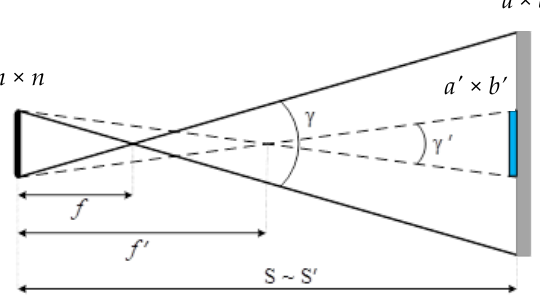
Figure 7. Image acquisition via system camera CCD matrix.